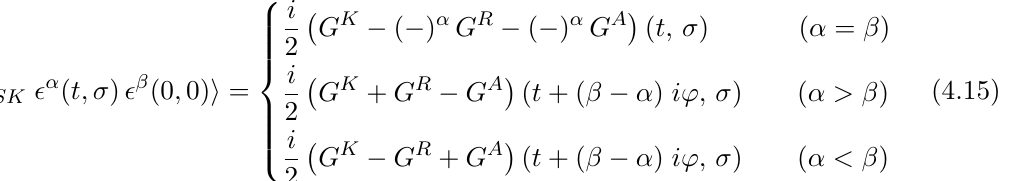
Figure 2 . We choose the k -OTO contour in the complex time plane to be such that all legs are equally separated by ’ in the imaginary direction. We often set either ’ = (cid:25) or ’ = (cid:14) (cid:28) 1 (small separation limit). The legs of the contour are labelled by indices (cid:11); (cid:12); : : : = 1 ; : : : ; 2 k